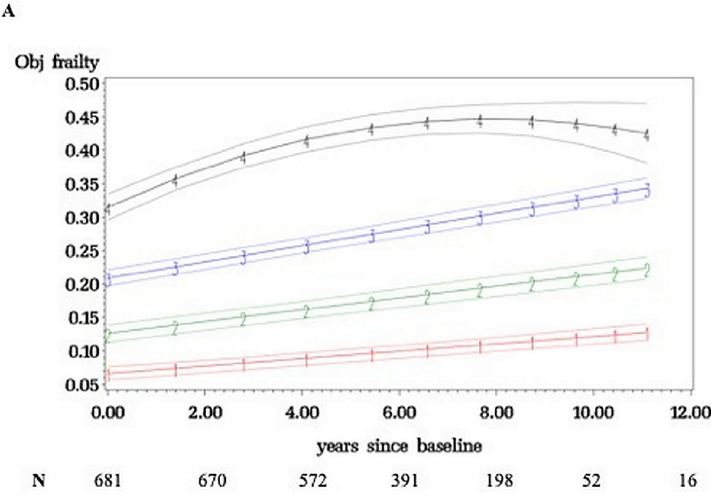
Fig 1. Frailty trajectories with 95% confidence intervals in LonGenity cohort. Four trajectory classes identified: relatively stable (1), mild frail (2), moderate frail (3) and severely frail (4). The Y-axis depicts the frailty index scores (range 0 to 1) and x-axis follow-up time in